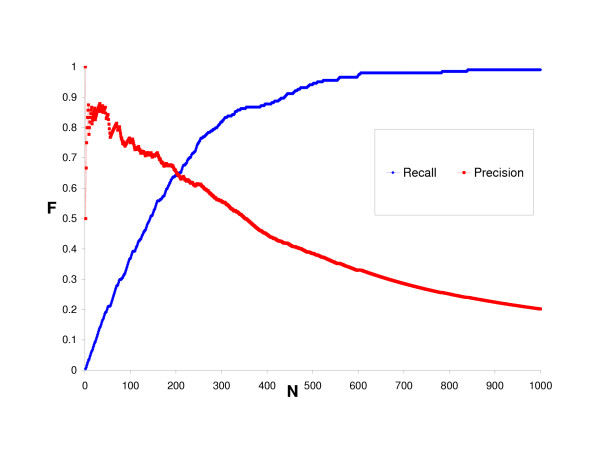
Recall and precision of the algorithm. The recall and the precision of the algorithm were checked in a set of 6,923 references not included in the training set. Manual examination of the set resulted in the identification of 204 references (positives) relevant to stem cells. Recall was measured as TP/(TP+FN) and precision as TP/(TP+FP), where TP is true positives, FP is false positives, and FN is false negatives.